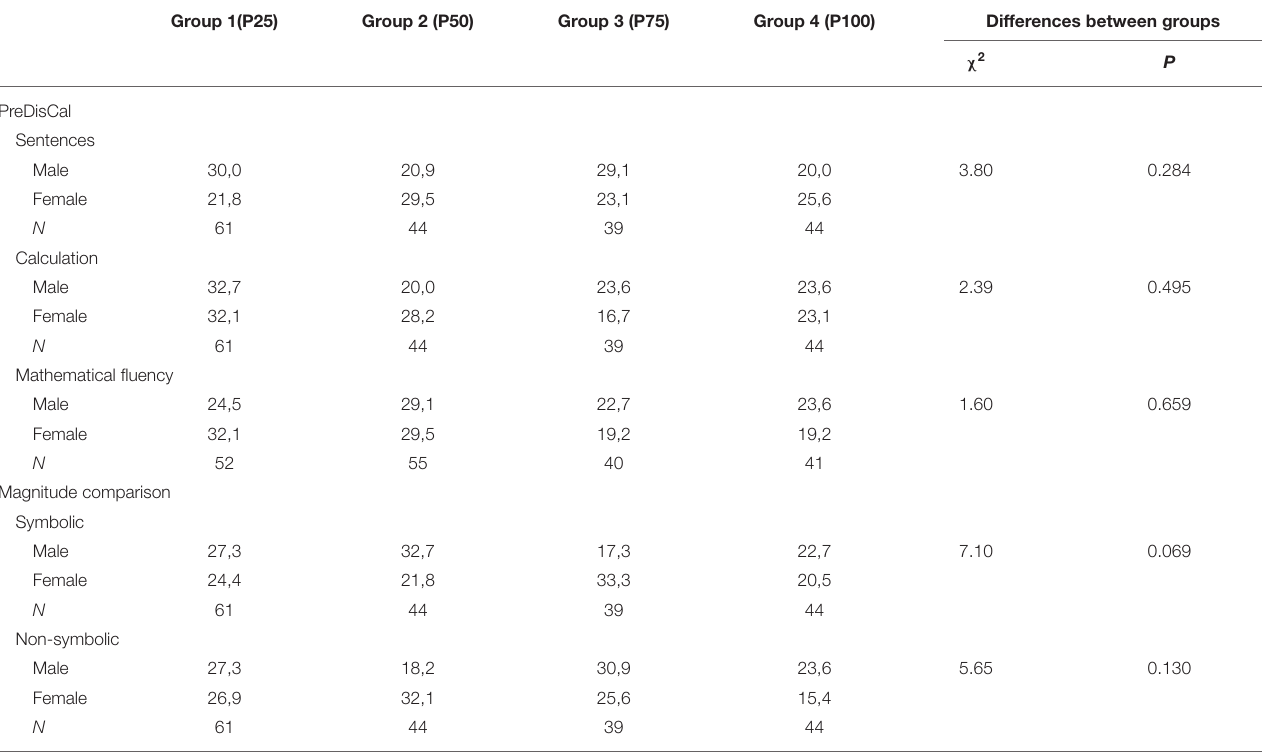
TABLE 3 | Percentage and comparison of third grade boys and girls by groups corresponding to the 25th, 50th, 75th, and 100th